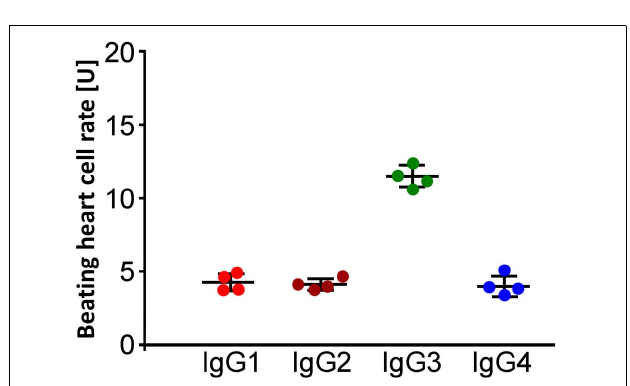
FIGURE 4 | Identification of the IgG3 subclass of the inhibitory anti– β 2 -AAbs in patients with PEX syndrome (PEXS). IgG subclass analysis was done by IgG, prepared from sera of patients with PEXS by direct ammonium sulfate precipitation. The samples were treated with murine monoclonal anti-human IgG1, IgG2, IgG3, and IgG4 antibodies prior to application to the cardiomyocyte bioassay. Beating heart cell rates after immune precipitation of IgG1 (red), IgG2 (dark orange), IgG3 (green), and IgG4 (blue) in the presence of additional application of clenbuterol (Cb); absolute date, mean ± standard deviation (SD); 1 unit (U) reflects 4 beats/min. Only immune precipitation of IgG3 removed the inhibitory effect of inhibitory anti– β 2 -AAbs on the Cb effect. Consequently, the inhibitory anti– β 2 -AAbs are of IgG3